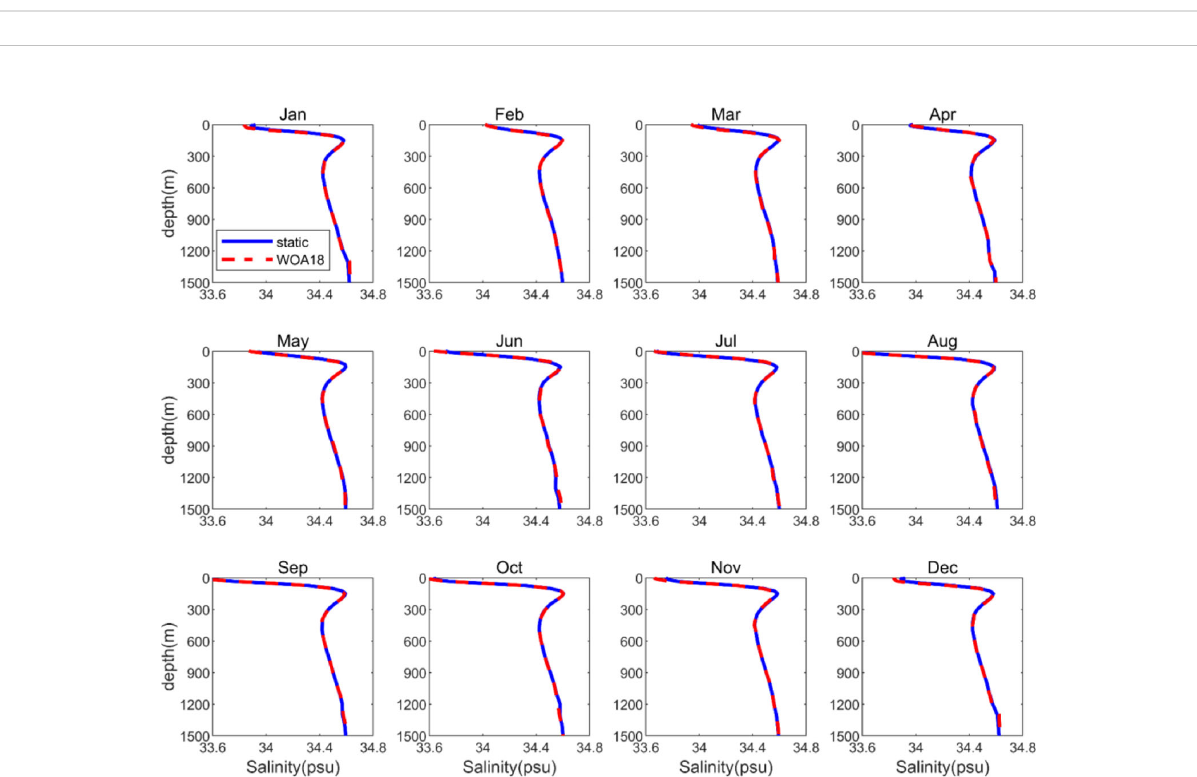
FIGURE 4 Monthly salinity pro fi les in the northern South China Sea. The blue and red lines represent the static climatic fi eld and WOA18 data,